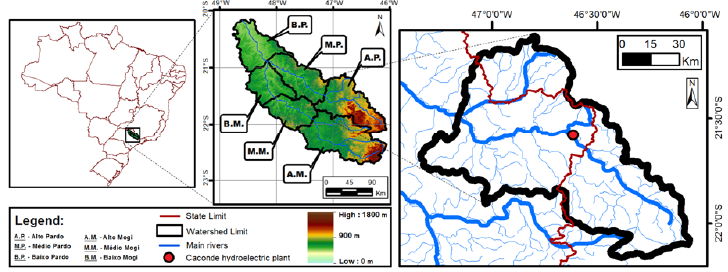
Figure 1. The Alto Pardo watershed.